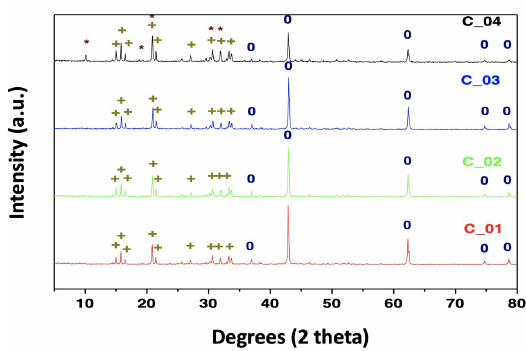
Figure 2. X-ray diffractograms of CBPC compositions prepared from MgO powders calcined at 1100 °C / 2 h, with different MgO/NH ratio, in mass. (Phases: + struvite; * dittmarite; o MgO).